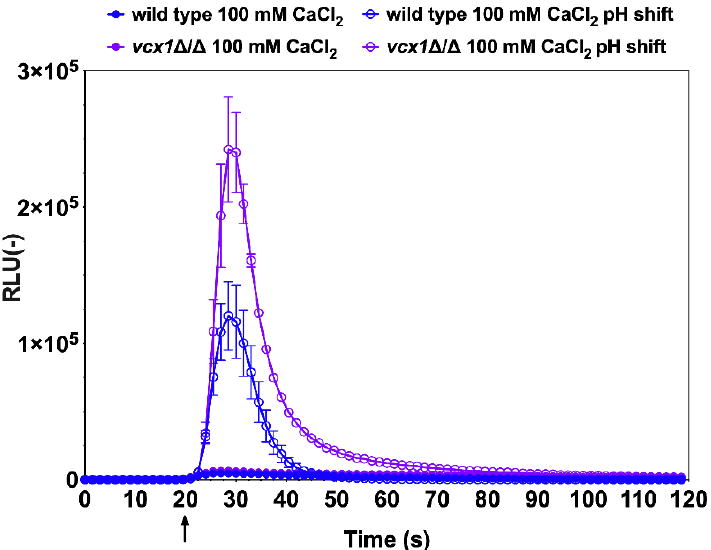
Figure 3. Relevance of the H + /Ca 2+ exchanger, Vcx1, in Ca 2+ homeostasis in C. albicans . Wild-type cells (DSY3892 and DSY4063) and the vcx1 ∆ / ∆ mutant were prepared as described in the Materials and Methods. Injections of 0.25 M Tris-HCl (pH 7.5) and CaCl 2 (1 M) were performed after 20 s of pre-incubation in GLAC medium (arrow). Results were obtained from duplicate experiments and data were subtracted from background cells devoid of aequorin expression (CAF2-1). Comparisons of RLU values between the CaCl 2 -treated wild-type and vcx1 ∆ / ∆ mutants were not significant all time points, although they were significant ( p < 0.001) in alkaline conditions after injections and up to 80 s of experiment time had elapsed.